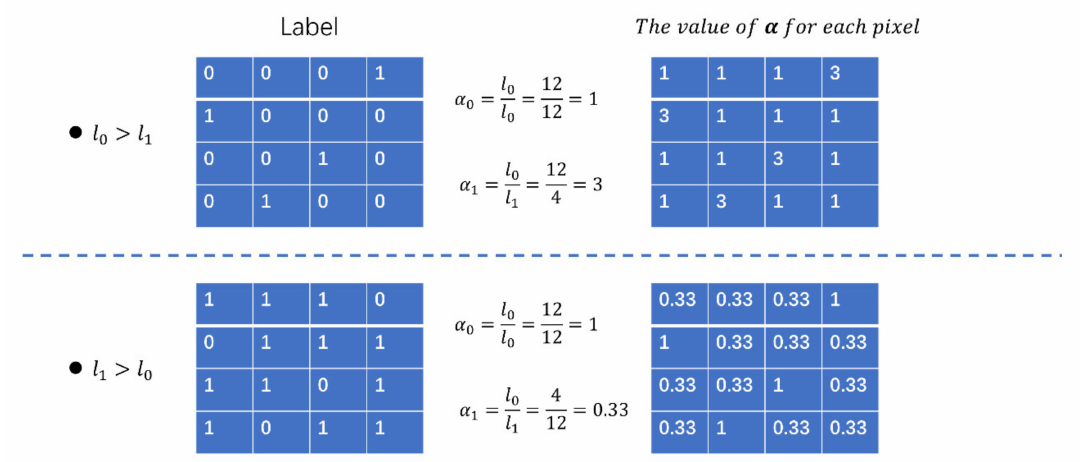
Figure 7. Two simple examples of the class-balance component ( α